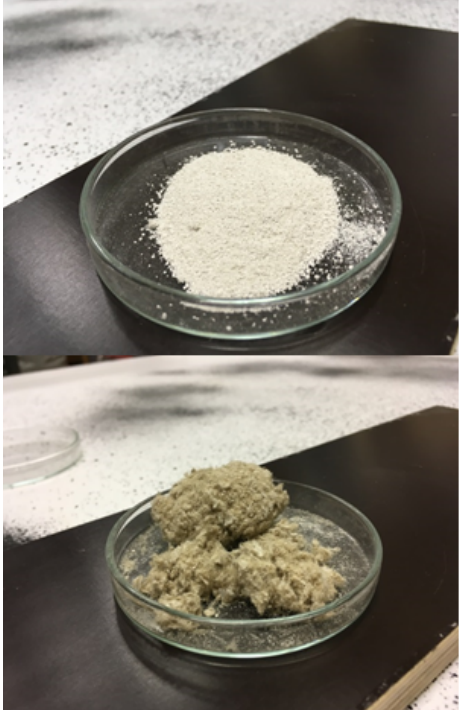
Figure 2. Fine milled gypsum and separated paper.